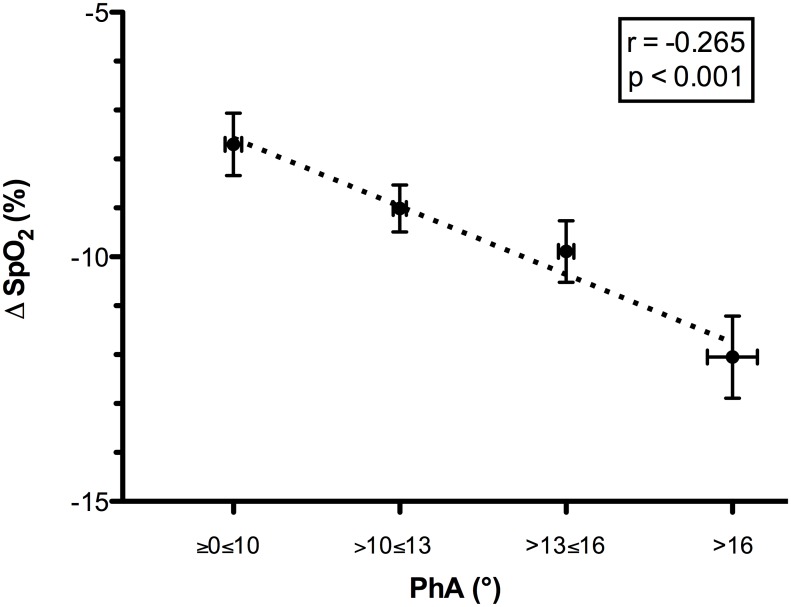
Relationship between the mean decrease in oxygen saturation and thoraco-abdominal coordination (PhA) during the run.The PhA values were grouped into four classes, each associated with the mean decrease in SpO2 (SpO2 at rest—mean SpO2 during the race). Reductions in thoraco-abdominal coordination, indicated by an increase in PhA, were significantly related to decreases in SpO2. Abbreviations: PhA, phase angle; Δ SpO2, mean decrease in oxygen saturation.